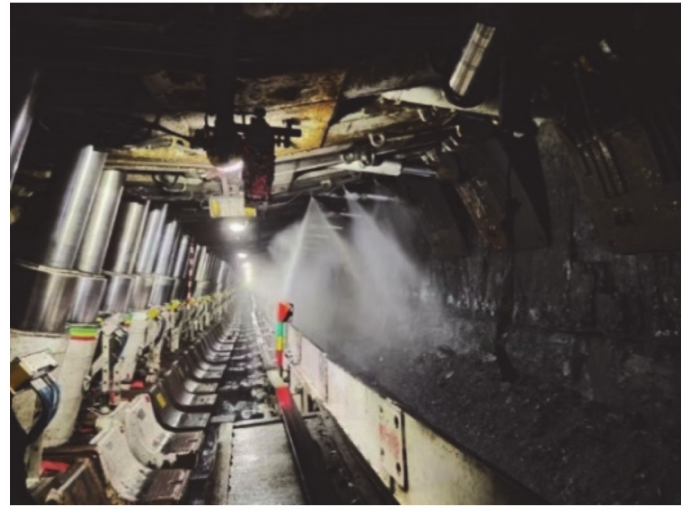
Figure 11. Real treatment effects of inter-rack